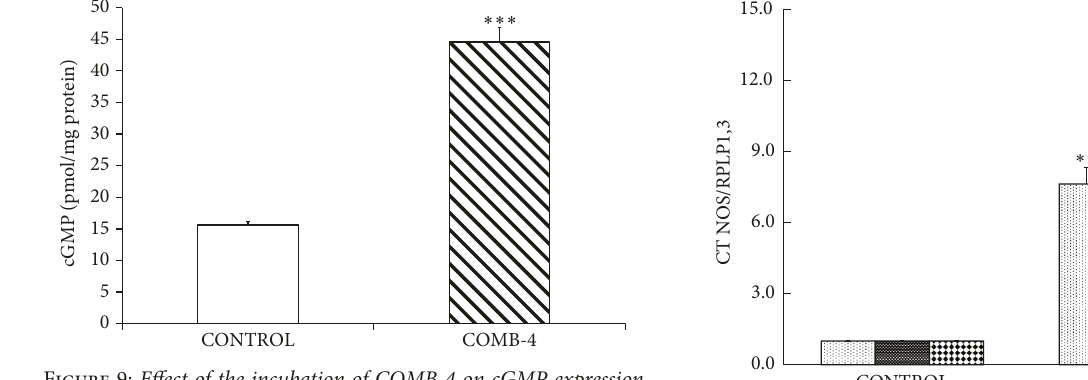
Figure 9: Effect of the incubation of COMB-4 on cGMP expression in differentiated MC3T3-E1 cell line. After MC3T3-E1 cells were differentiated with ascorbic acid and 𝛽 -glycerophosphate for seven days, osteoblast cells were incubated for 24 hours with or without COMB-4. cGMP expression was determined by ELISA. Results are expressed as pmol/mg of protein and represent the mean ± SEM of four experiments done in duplicate. ∗ ∗ ∗ p < 0.01 with respect to control.